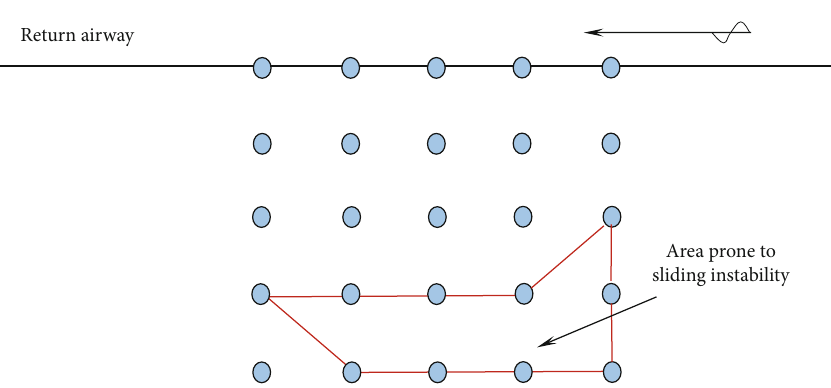
Figure 8: L = 200 m, H = 1 : 5 M of the face prone to instability